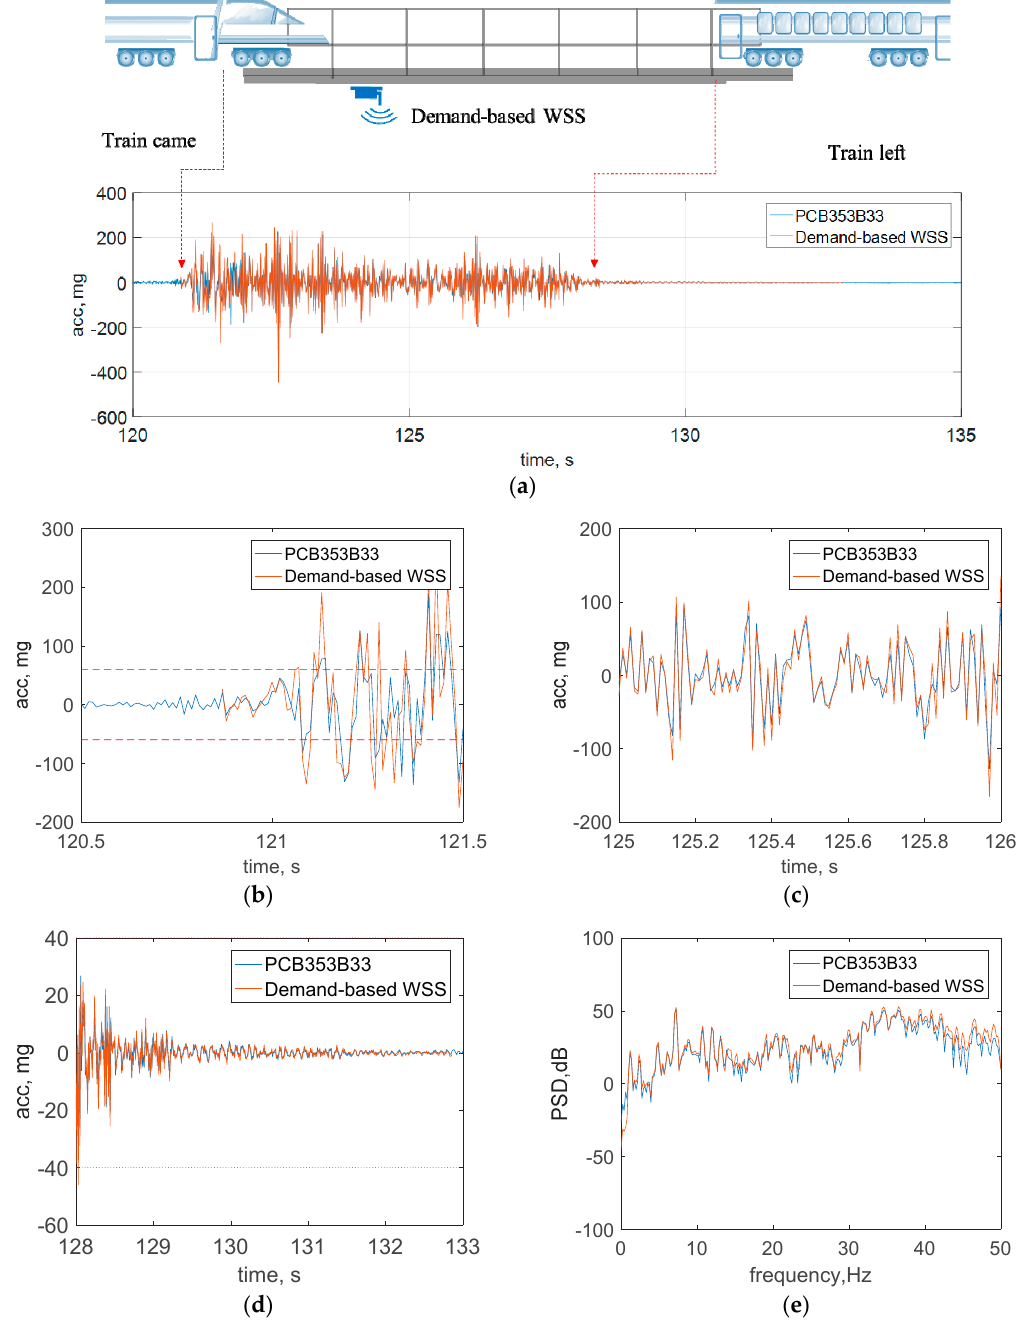
Figure 12. Test results on a railroad bridge: ( a ) time history data, ( b ) zoomed view of event starts (ADXL362 data), ( c ) zoomed view of event data (Xnode data), ( d ) zoomed view of event ends (Xnode data), ( e ) PSD data.